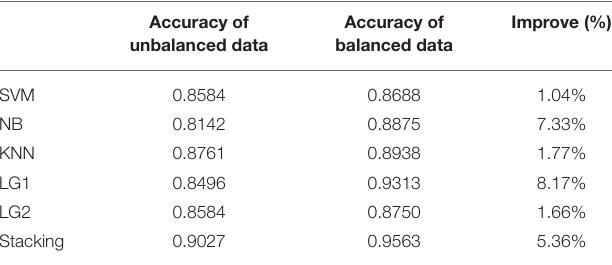
TABLE 4 | Prediction accuracy of classifiers before and after eliminating class